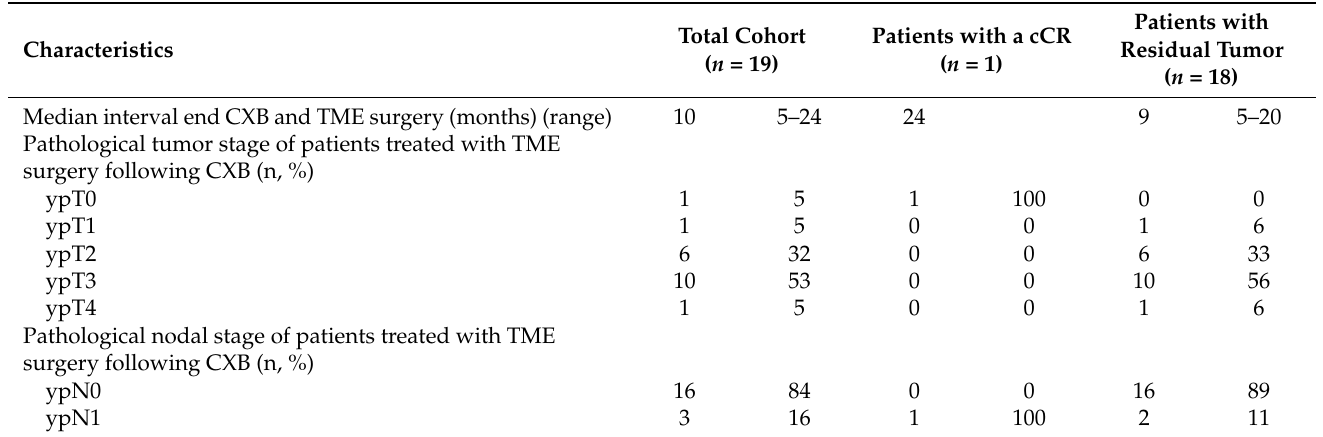
Table 2. Characteristics of TME